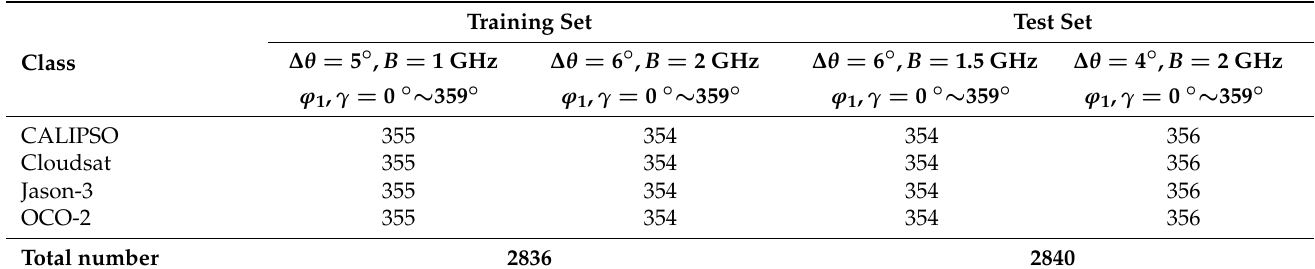
Table 1. Detailed parameter settings of training and test sets for scaled deformation